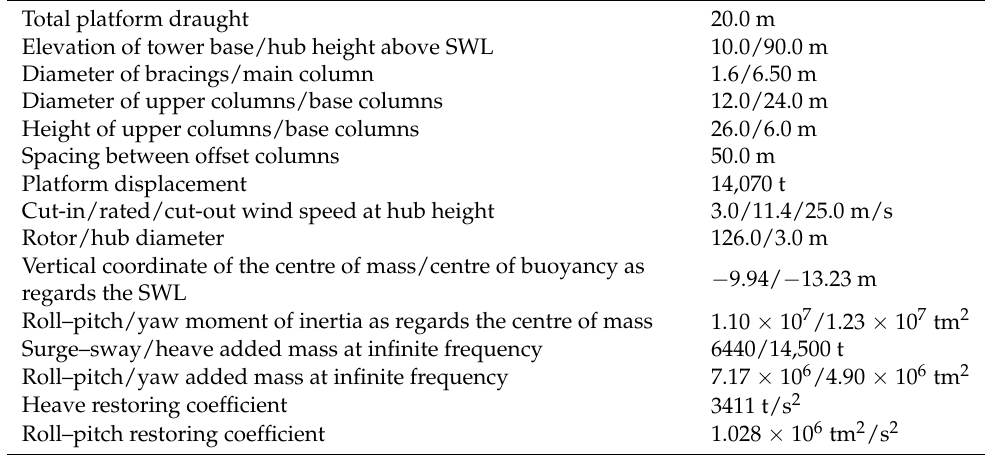
Table 1. Main properties of the OC4-DeepCwind